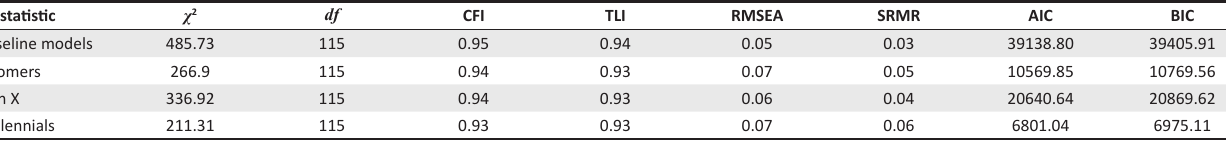
TABLE 3: Measurement model fit